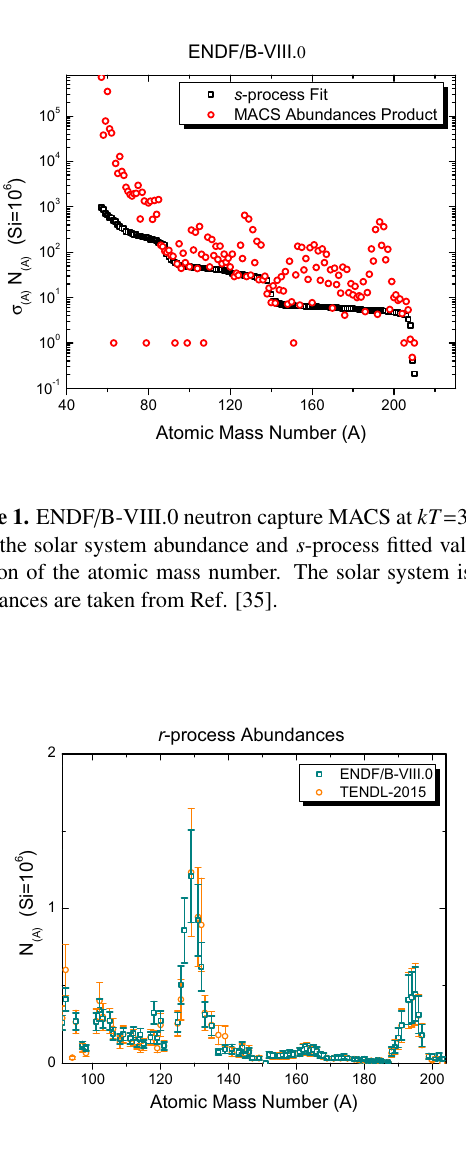
Figure 2. ENDF / B-VIII.0 and TENDL-2015 r -process abun- dances.